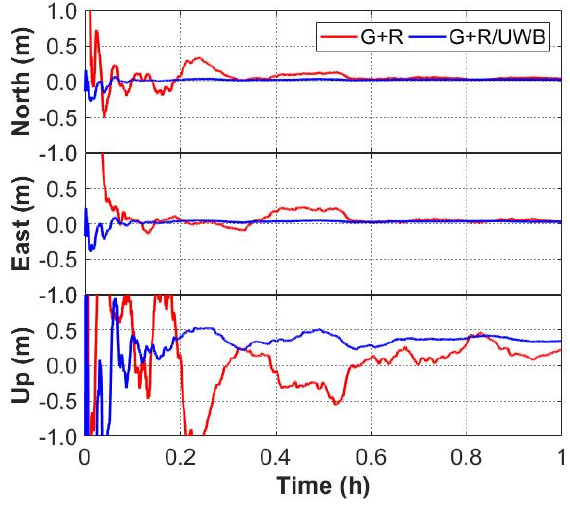
Figure 9. Positioning errors of GPS + GLONASS and GPS + GLONASS/UWB solutions with a cutoff elevation angle of 40°. Table 2. RMS values of the positioning errors for GNSS/UWB and GNSS-only solutions with a cutoff elevation angle of 40°.